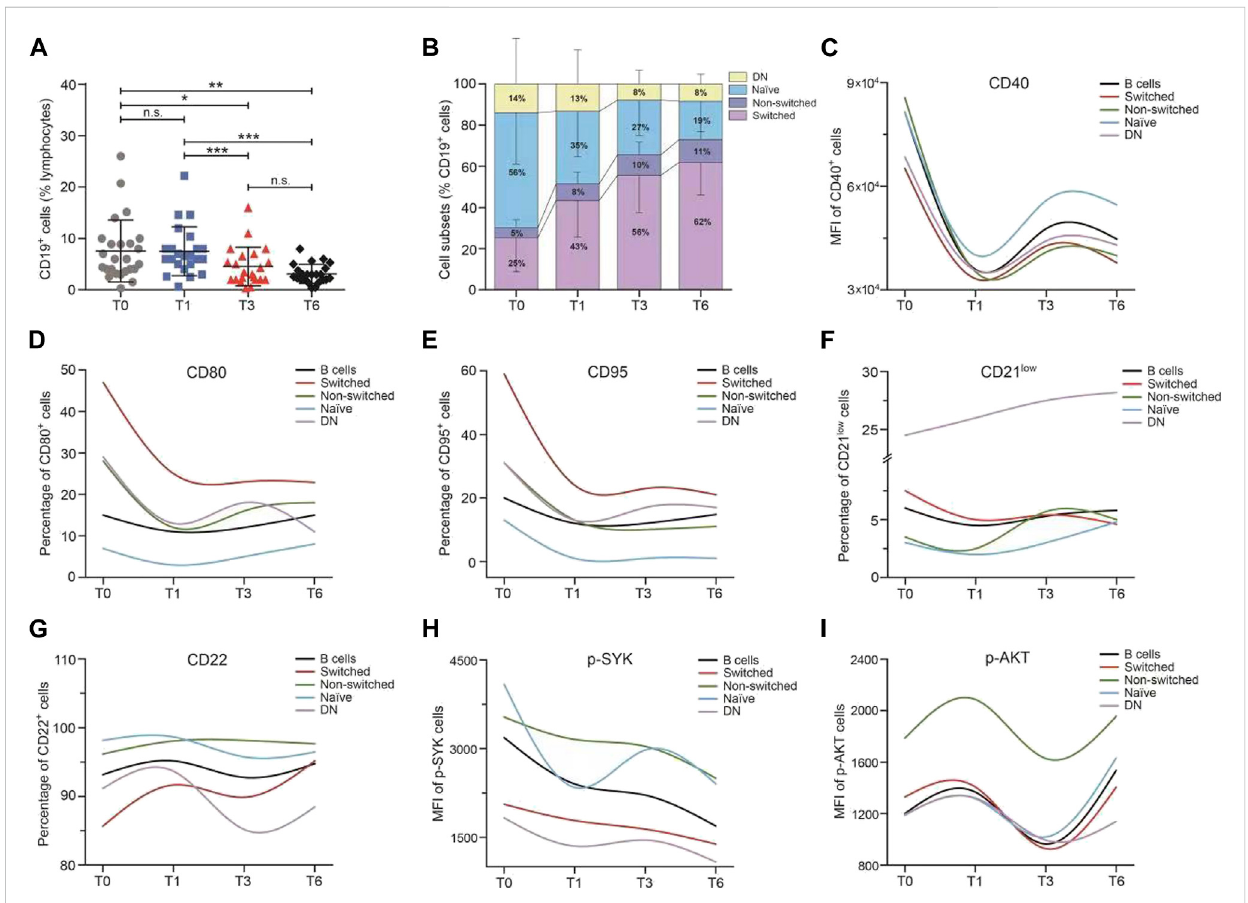
FIGURE 3 Median change from baseline over time for B-cell subsets and B-cell activation regulators in the SLE patients during belimumab treatment. (A – I) ChangeinthepercentageofCD19 + Bcells,frequenciesofB-cellsubsets,MFIofCD40,percentageofCD80,CD95,CD21 low ,andCD22,andMFIofp-SYK and p-AKT. Abbreviations: DN, double-negative; SLE, systemic lupus erythematosus; T,